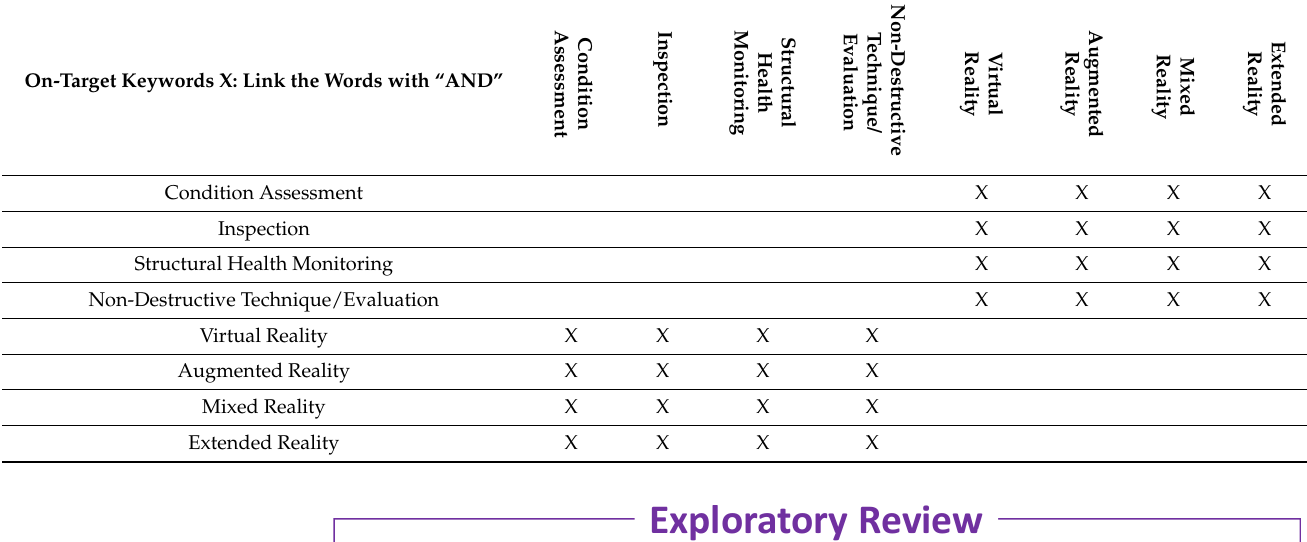
Table 2. On-target keywords used in the literature search for the Refined Review.